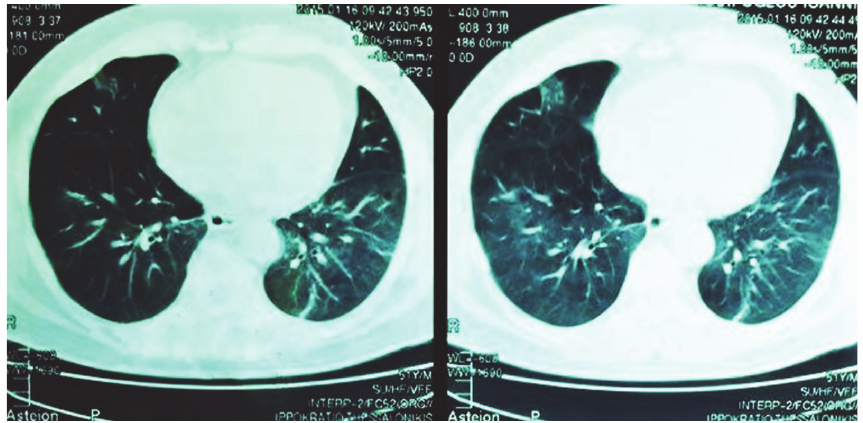
Figure 1: Computed tomography of the lungs showing diffuse bilateral opacities in the lower